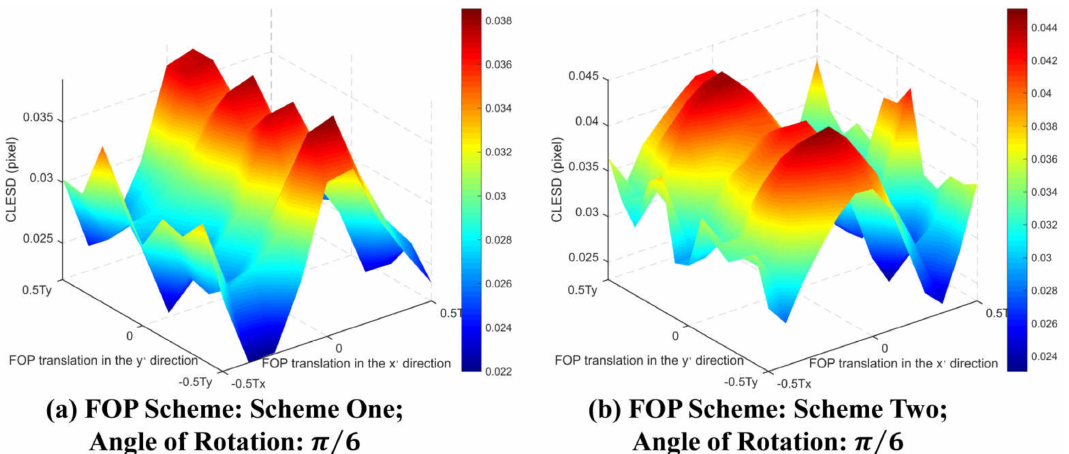
Figure 8. The FOP was translated for one period in the x (cid:48) and y (cid:48) directions. The FOP translation period in the x (cid:48) direction was ( T x = 2 R ) , and the FOP translation period in the y (cid:48) direction was translation and the CLESD was established. ( a ) FOP scheme one: d f = 4 µ m; K = 0.7; angle of rotation: No rotation. ( b ) FOP scheme two: d f = 6 µ m; K = 0.7; angle of rotation: No rotation.